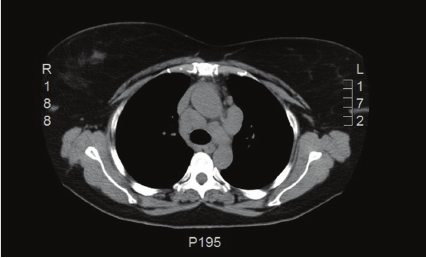
Figure 1: HRCT of the thorax demonstrating mediastinal lymph nodes and the largest was 2.3 × 3.1 centimeters.